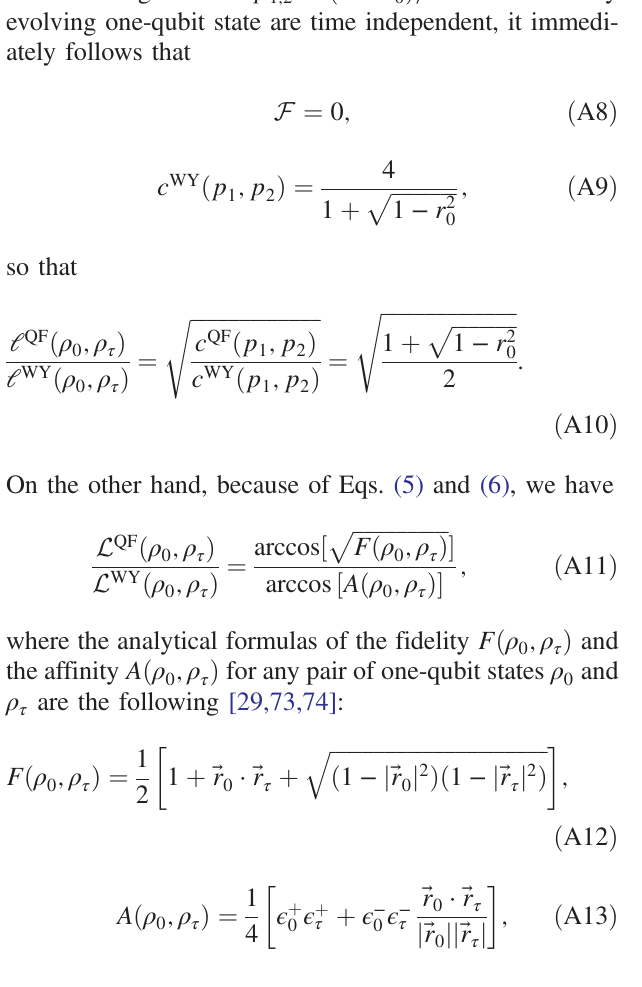
ffiffiffiffiffiffiffiffiffiffiffiffi p ffiffiffiffiffiffiffiffiffiffiffiffi 1 − r 2 0